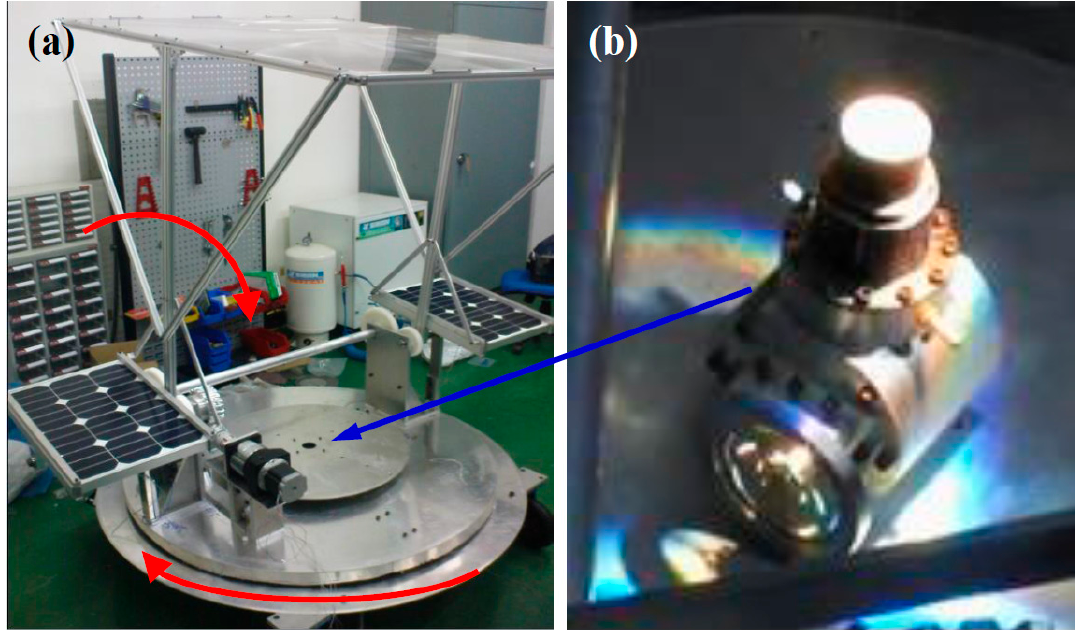
Figure 1. Biaxial ‐ type tracking system: ( a ) System photo; ( b ) Sunlight focused on the heating head of the Stirling engine at the center of solar tracker (arrow pointing).